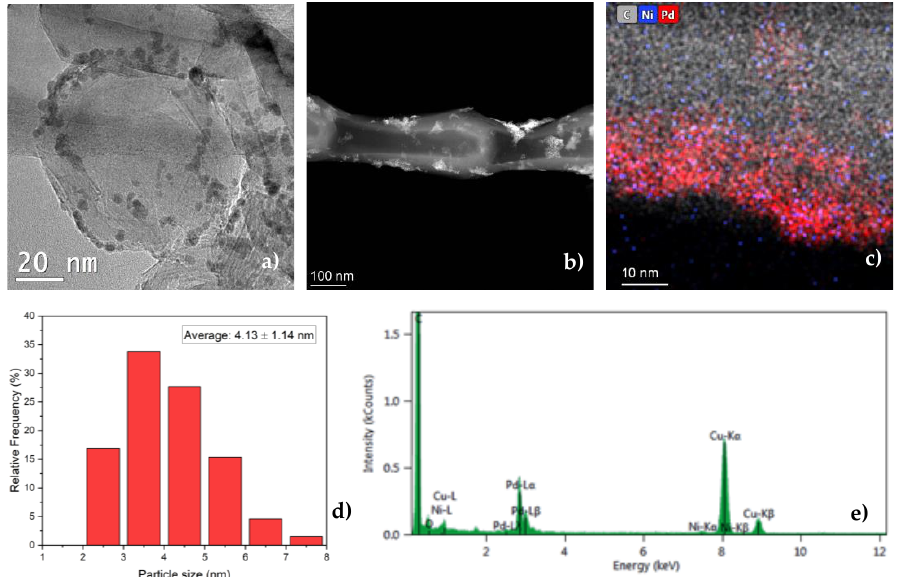
Figure 5. ( a ) TEM, ( b ) HAADF-STEM, ( c – e ) XEDS mapping and spectrum of a representative area, and ( d ) particle size distribution of 1%Pd 8 Ni 2 /HHT.